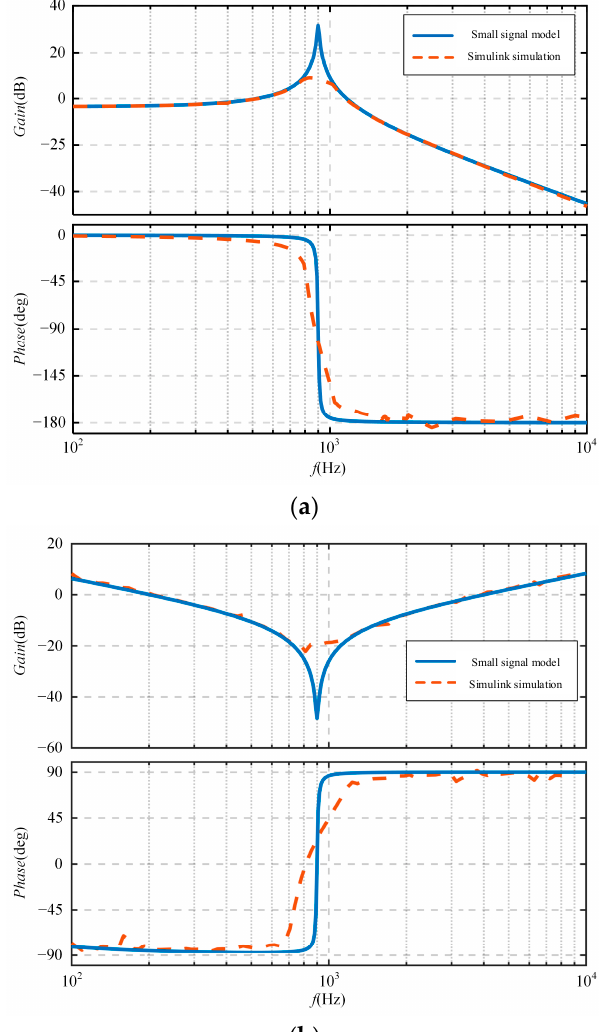
Figure 8. Bode plots of full-bridge LLC resonant converter. ( a ) Bode diagram of voltage transfer function; ( b ) Bode diagram of input impedance.